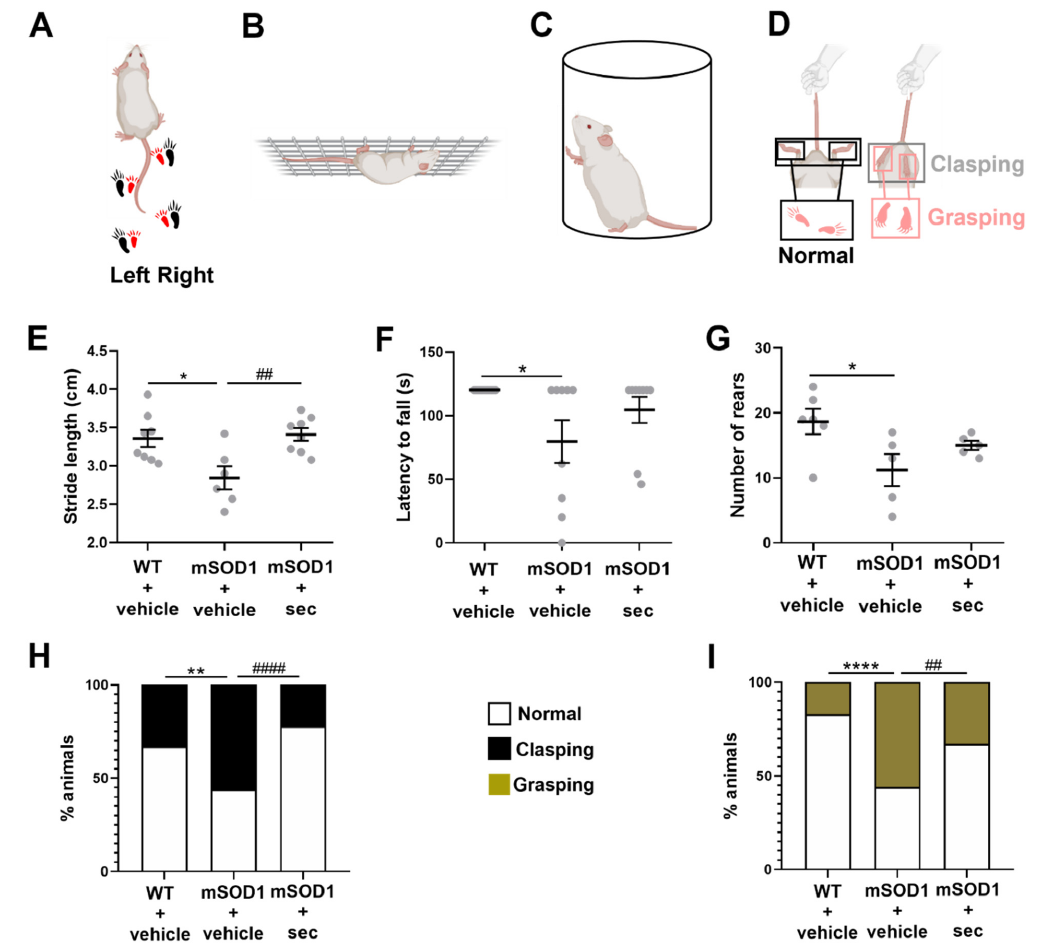
Figure 4. Motor performance, muscular strength, spontaneous activity, and corticospinal function in ALS mice are improved after 2 weeks of intrathecal injection of the secretome from anti-miR-124- treated mSOD1 motor neurons (MNs). Representative illustrations of ( A ) footprint test, ( B ) hanging wire test, ( C ) cylinder test, and ( D ) clasping/grasping reflexes test. Measurement of the ( E ) stride length (in centimeters, cm), ( F ) time holding onto the cage grid (in seconds, s), ( G ) number of times the mice reared up against the cylinder, and percentage (%) of animals showing the ( H ) clasping and ( I ) grasping reflexes in wild-type (WT)/SOD1-G93A (mSOD1) mice injected with the vehicle (basal media of NSC-34 MNs) and mSOD1 mice injected with the secretome derived from mSOD1 MNs modulated with anti-miR-124 (mSOD1 + sec). Data are expressed as mean ± SEM for ( E – G ) and percentage (%) for ( H , I ) from at least 5 animals per group. **** p < 0.0001, ** p < 0.01 and * p < 0.05 vs. WT + vehicle; #### p < 0.0001 and ## p < 0.01 vs. mSOD1 + vehicle. One-way ANOVA followed by multiple-comparisons Bonferroni post hoc correction was used for footprint and cylinder tests; unpaired and one-way non-parametric ANOVA (Kruskal–Wallis test) was used for hanging wire test; chi-square (and Fisher’s exact) test was used for clasping and grasping tests. Panels ( A – D ) were partially created with Biorender